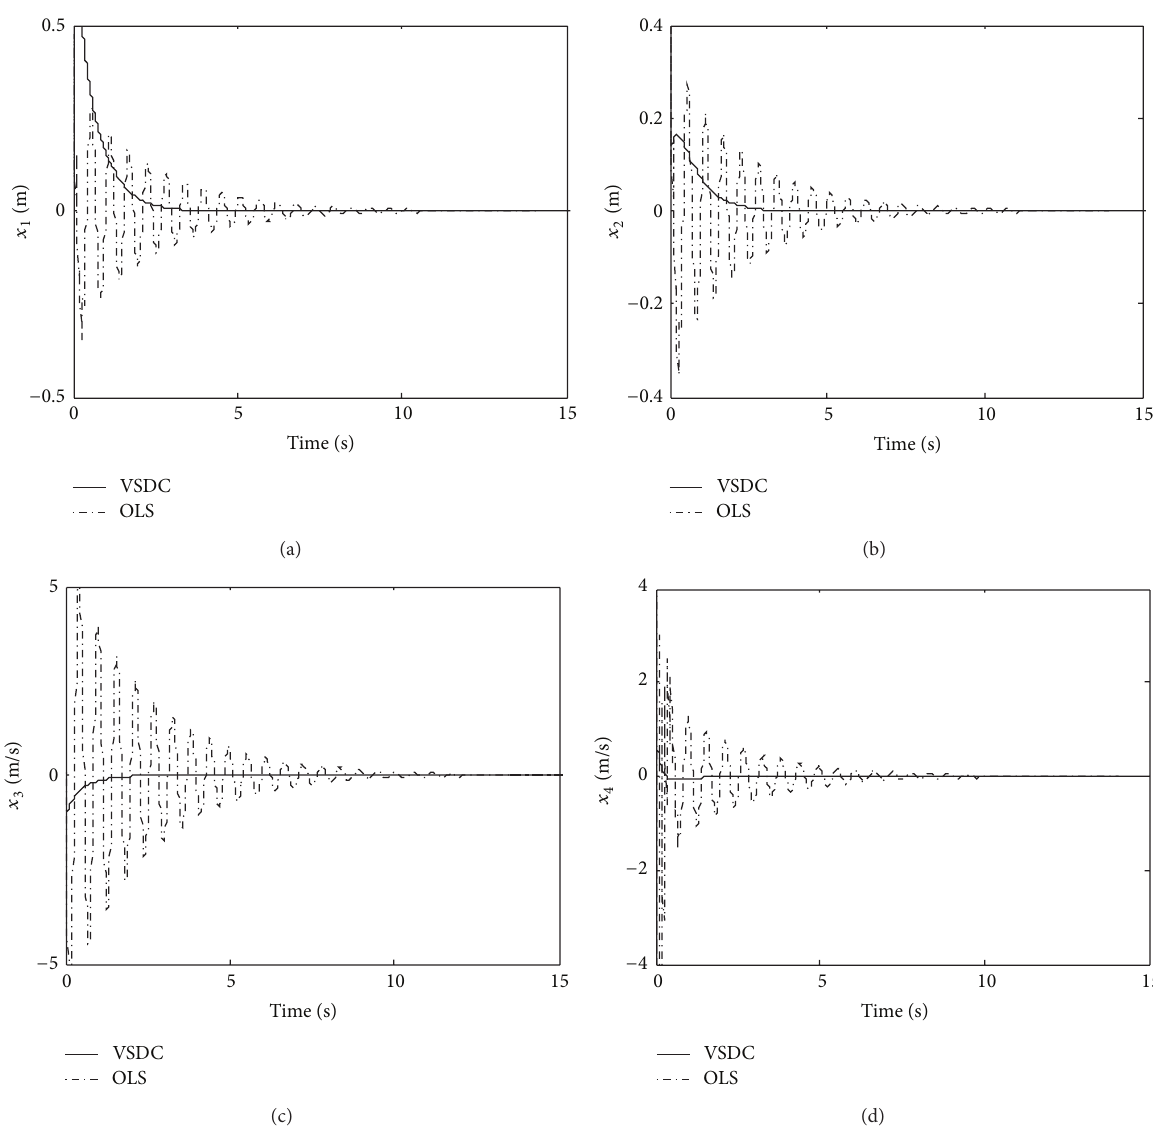
Figure 1: States trajectories of VSDC and OLS under sinusoidal